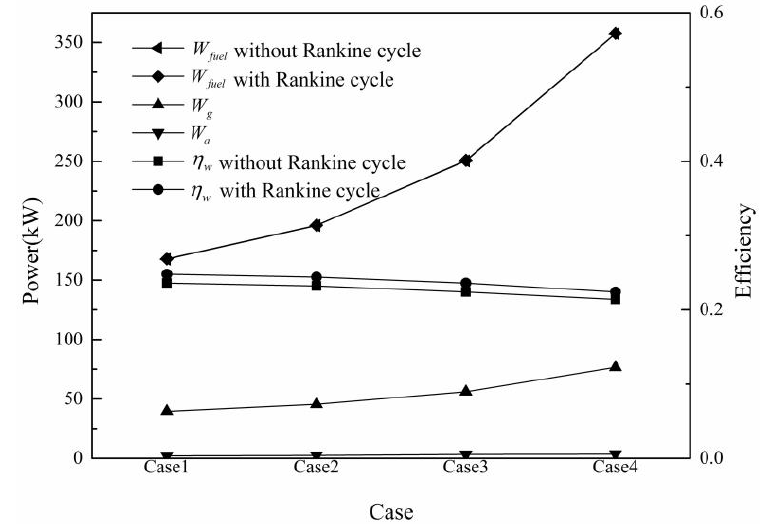
Figure 8. Overall combined cycle system efficiency.